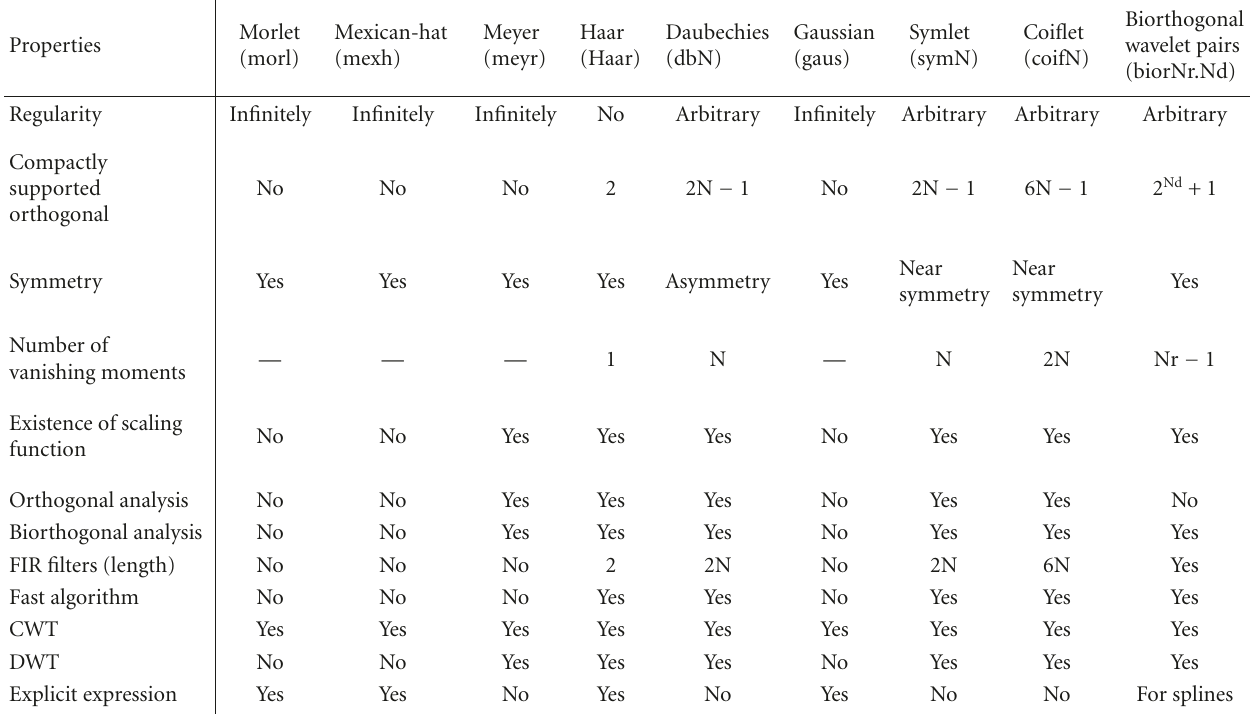
Table 6: Summary of wavelet